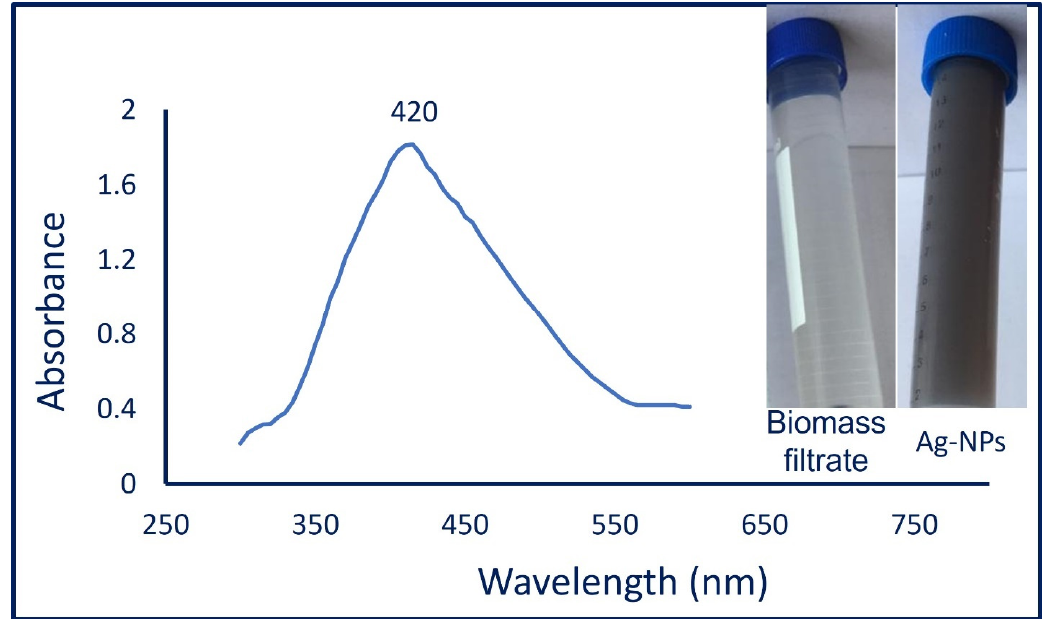
Figure 1. Color change and UV-Vis spectroscopy analysis of mycosynthesized Ag-NPs at wavelengths of 300–600 nm.